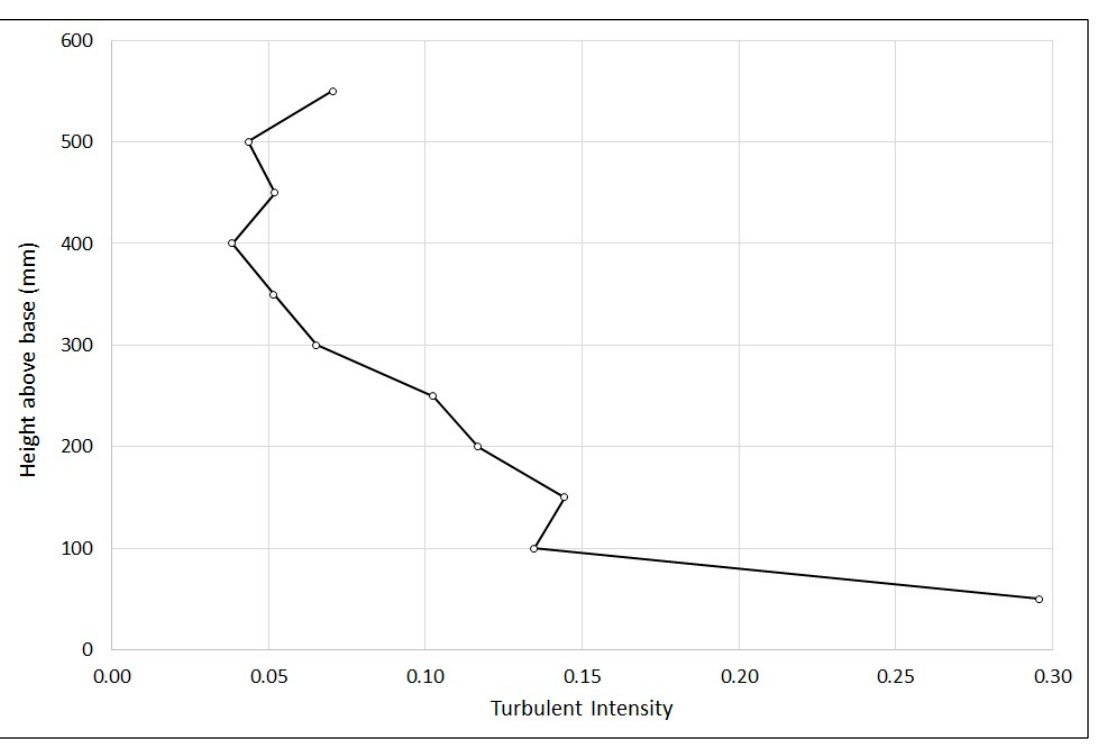
Figure 14. Turbulent intensity profile at turbine location (case 11) without turbine.